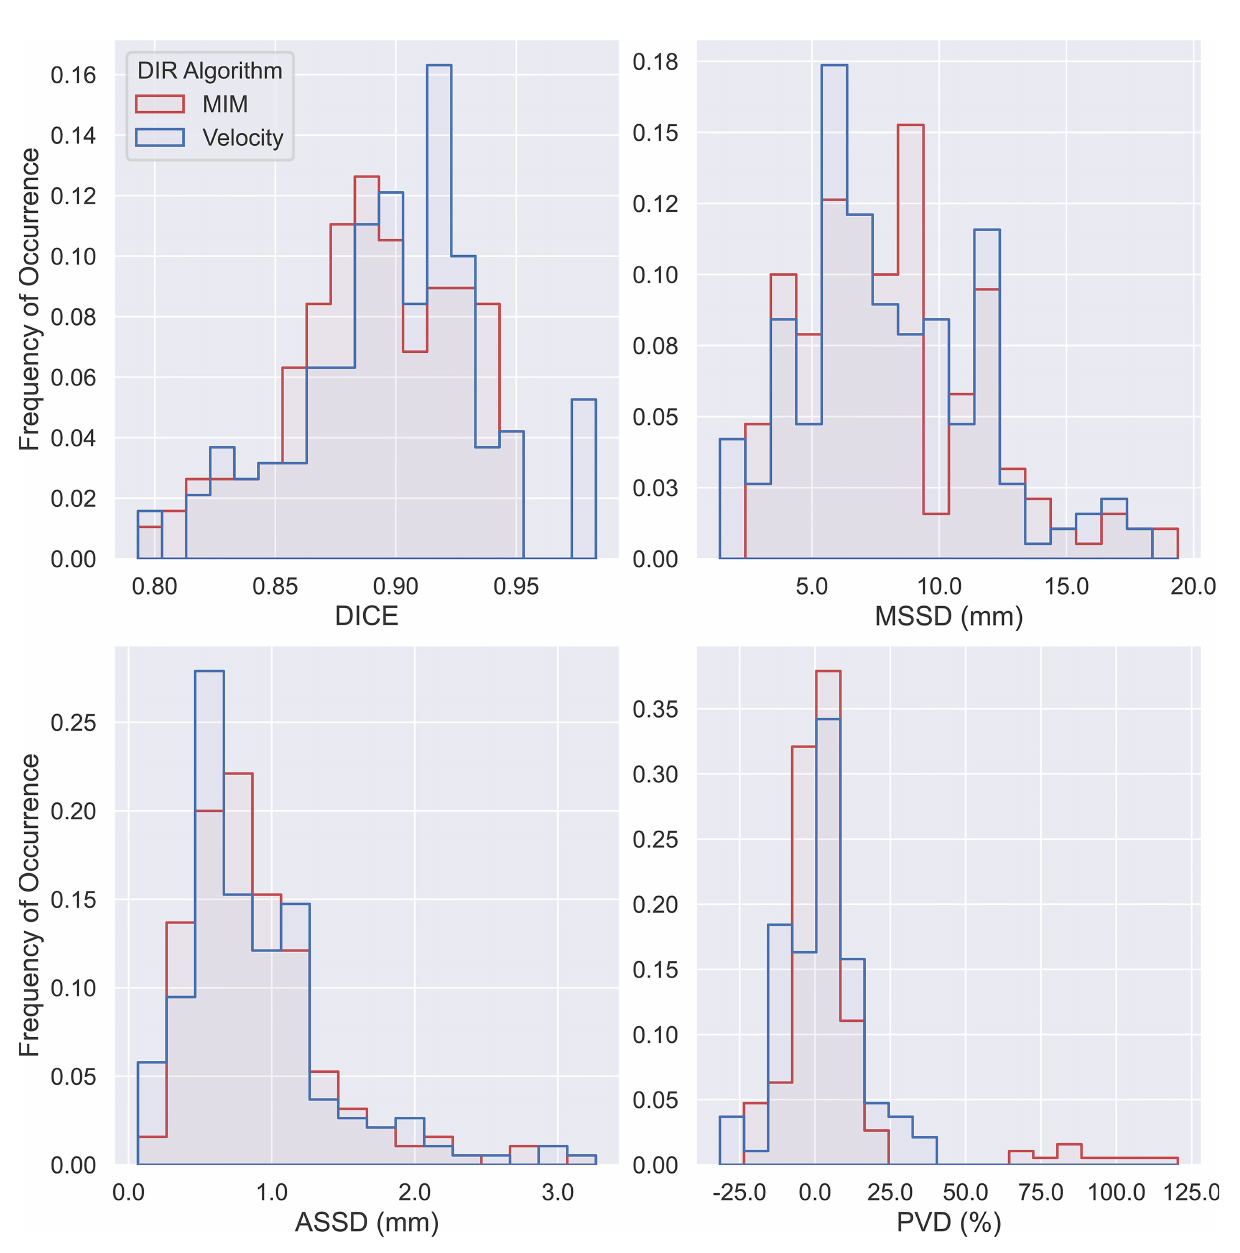
FIGURE 3 | Histogram of Dice coef fi cient (DICE), maximum symmetric surface distance (MSSD), average symmetric surface distance (ASSD), and percent volume difference (PVD) from pairwise comparisons of all 190 auto-propagated internal gross tumor volumes (AP-IGTVs) relative to their corresponding ground-truth internal gross tumor volumes (GT-IGTVs) for the two employed deformable image registration (DIR) algorithms (MIM in red; Velocity in